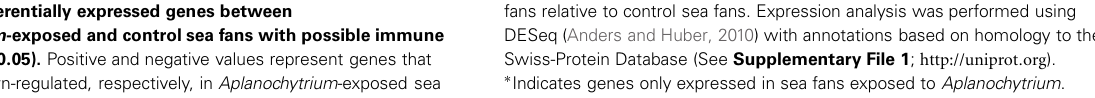
fans relative to control sea fans. Expression analysis was performed using DESeq (Anders and Huber, 2010) with annotations based on homology to the Swiss-Protein Database (See Supplementary File 1 ; http://uniprot . org ). ∗ Indicates genes only expressed in sea fans exposed to Aplanochytrium